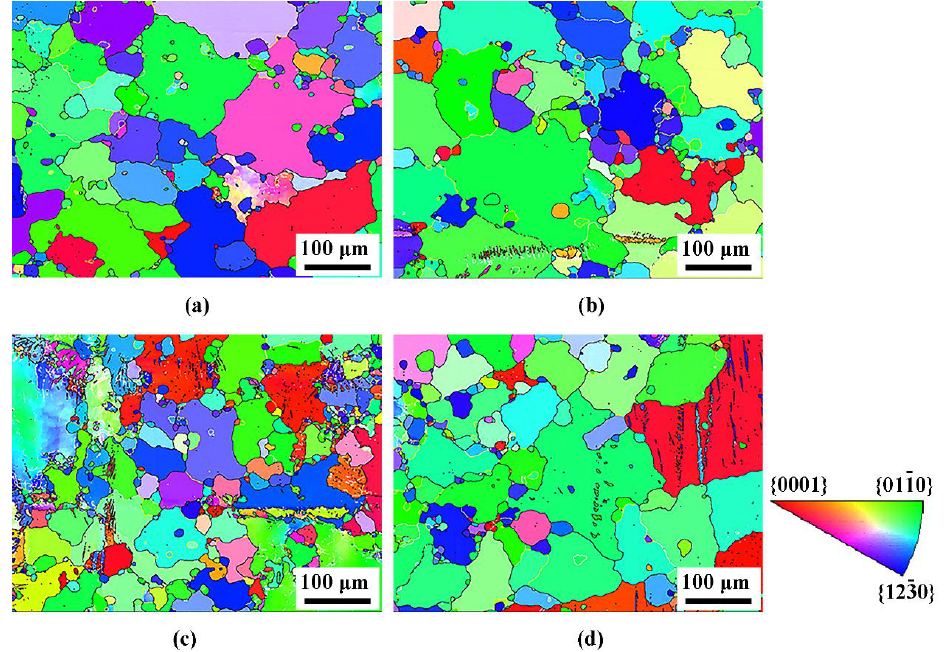
Figure 10. EBSD of AZ31B plates treated by ( a ) NUQ, ( b ) LNB, ( c ) LNHA and ( d ) LNR uphill quenching processes.